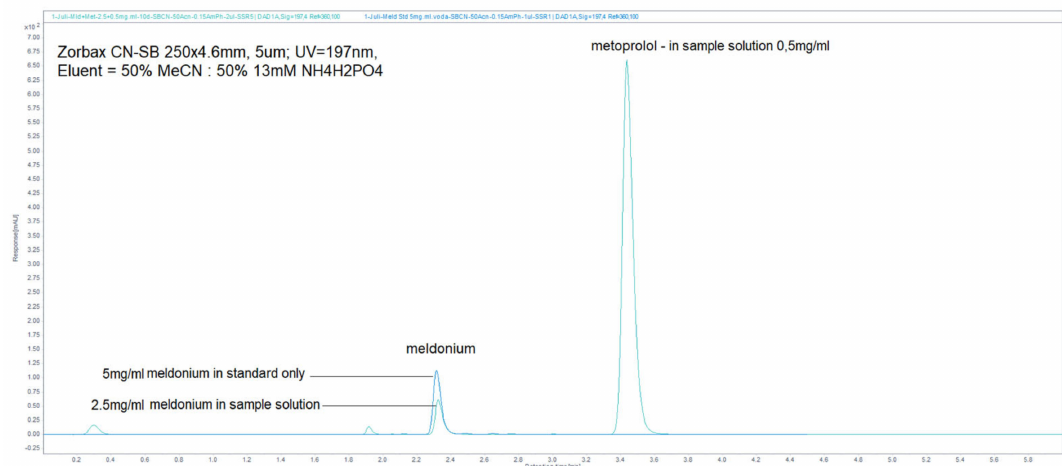
Figure 33. Chromatograms obtained with Zorbax CN-SB-250 × 4.6 mm in the term of confirmation of identities of meldonium and metoprolol with standard 50% ACN and 50% NH 4 H 2 PO 4